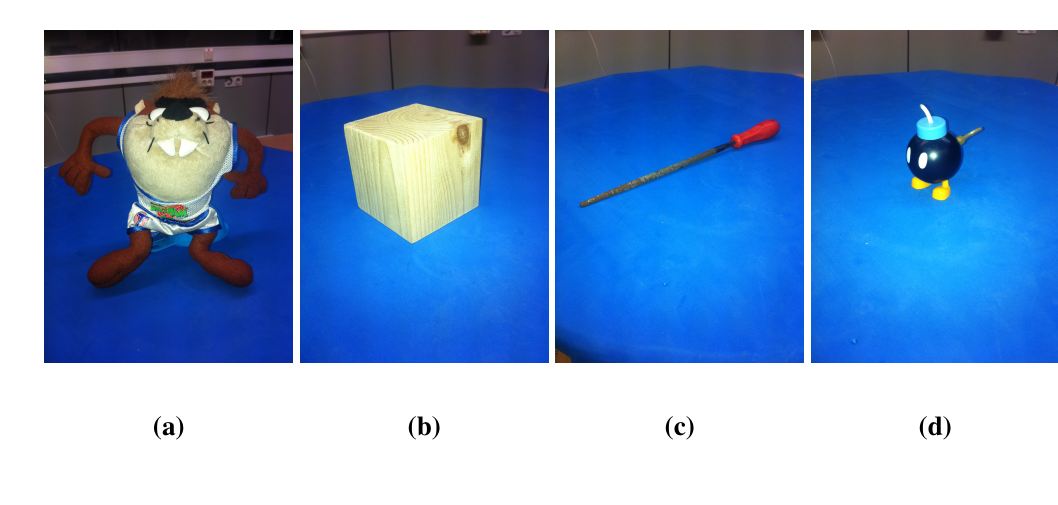
Figure 6. Objects used for experimentation. ( a ) Taz toy; ( b ) cube; ( c ) tool; and ( d ) bomb